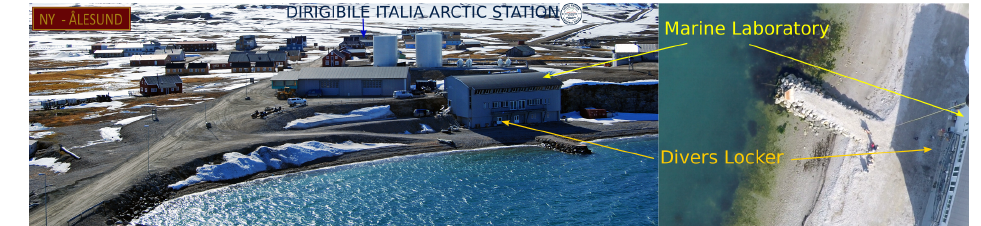
Figure 6. Ny-Ålesund and the infrastructures used by Italian National Research Council (CNR)-INstitute of Marine engineering (INM)